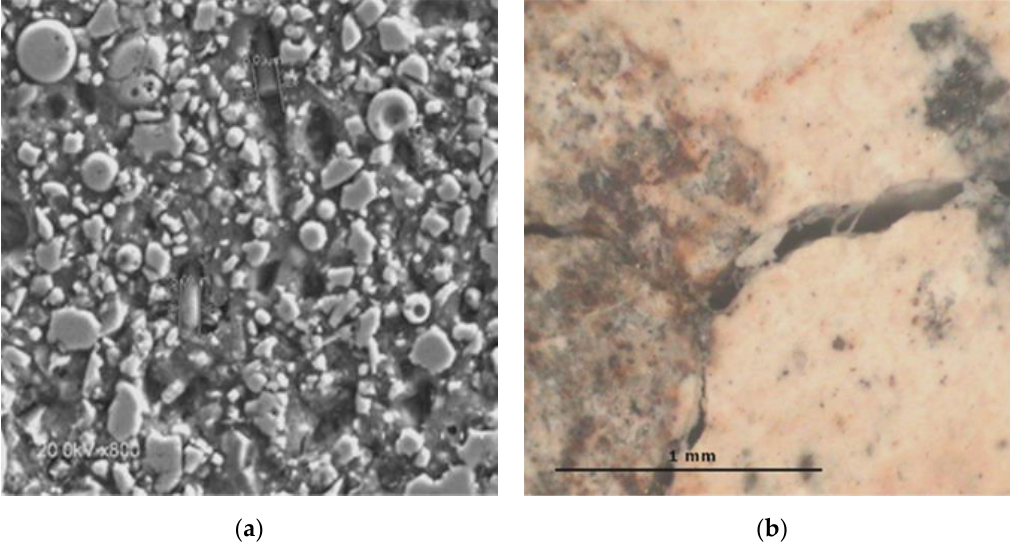
Figure 9. CMF in concrete after heating it to 550°C. ( a ) SEM after the first heat cycle, on the ( b ) after 25 heat cycles.